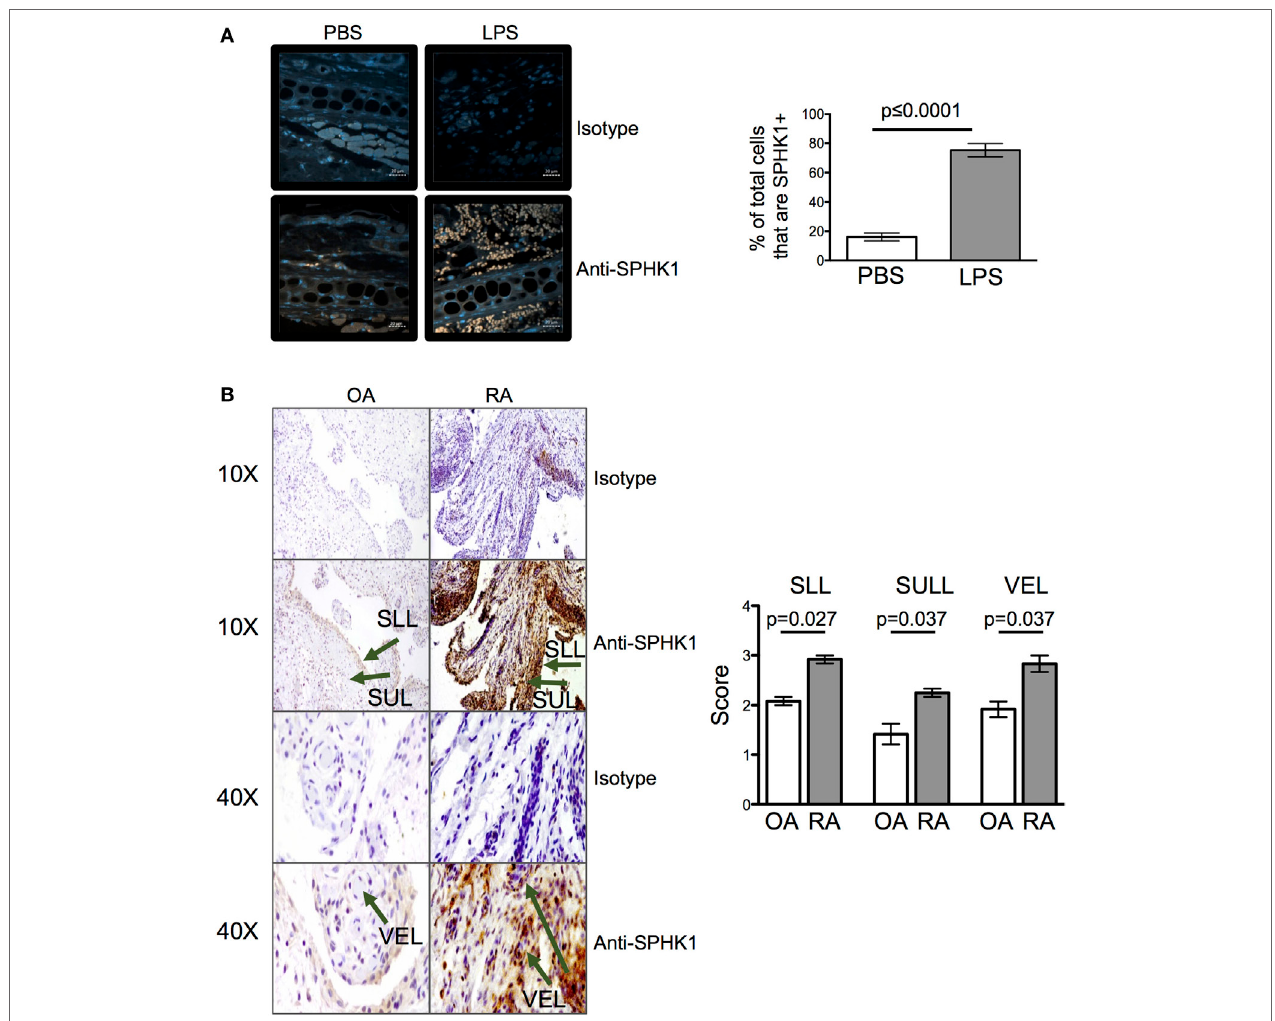
FigUre 8 | Inflammation leads to an increase in sphingosine kinase-1 (SPHK1). Levels of SPHK1 in the ear pinnae of mice injected with PBS or lipopolysaccharide (LPS) 24 h (a) previously or in sections prepared from osteoarthritis (OA) or rheumatoid arthritis (RA) patients (B) were examined. Sections were immunostained with anti-SHPK1 (brown) and DAPI (blue), scale bar in panel (a) is 20 µm (a) . Data are representative or combined from five animals per group or four OA and four RA patients. In panel (B) , SLL, synovial lining; SUL, synovial sub-lining; and VEL, vascular endothelial lining, and staining graded on a scale of 0–4 (0 = no cells, 1 = < 25%, 2 = < 25–50%, 3 = < 50–75%, 4 = 75%) by two blinded observers on two independent